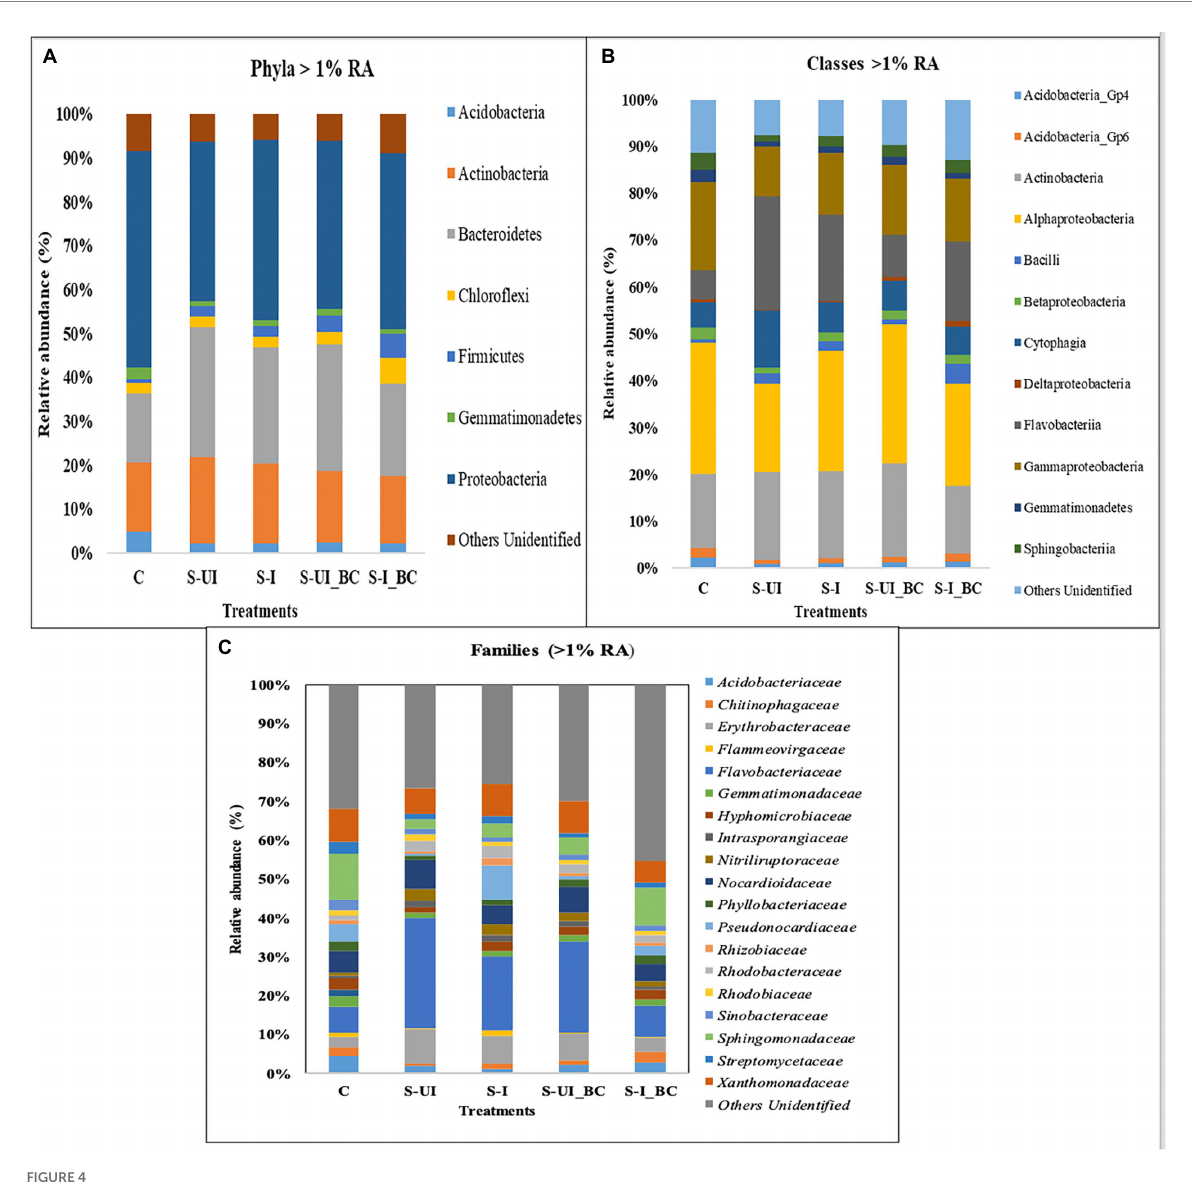
FIGURE 4 (A–C) Overview of the relative populations of soil bacterial communities with respect to (A) phylum, (B) class, and (C) family under various treatments.